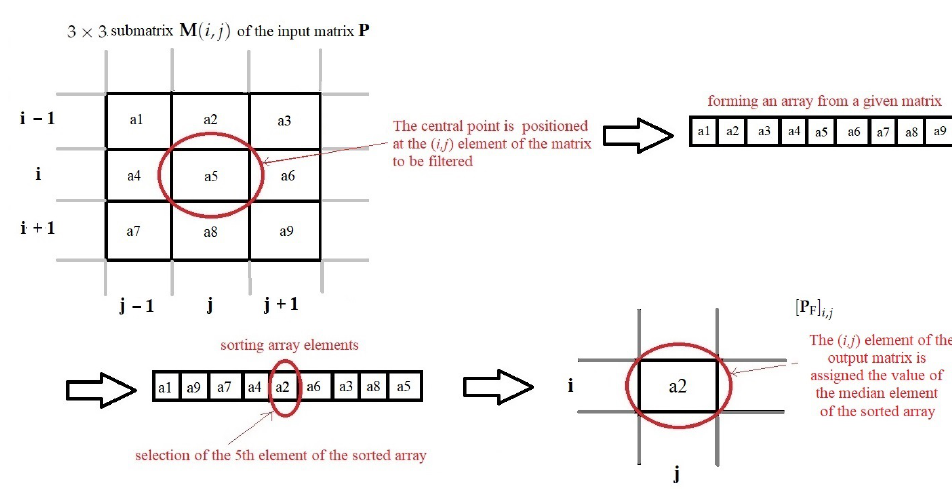
Figure 6. Median Filtering algorithm.